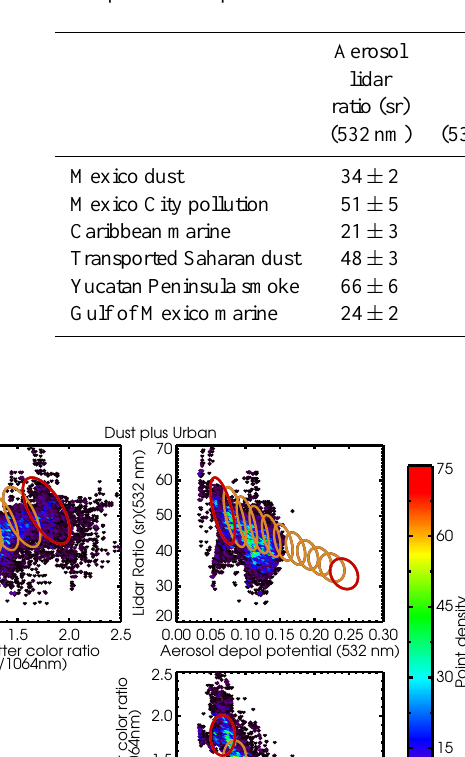
Table 1. The mean and standard deviation of the 532nm aerosol lidar ratio, aerosol backscatter color ratio (532nm/1064nm) and 532nm aerosol depolarization potential are given for the six samples of pure aerosol types measured by the HSRL-1 airborne lidar that are discussed in this study. The mean aerosol depolarization ratio is also given, since this is a more familiar quantity. See Section 3 for definitions of aerosol depolarization ratio and depolarization potential.